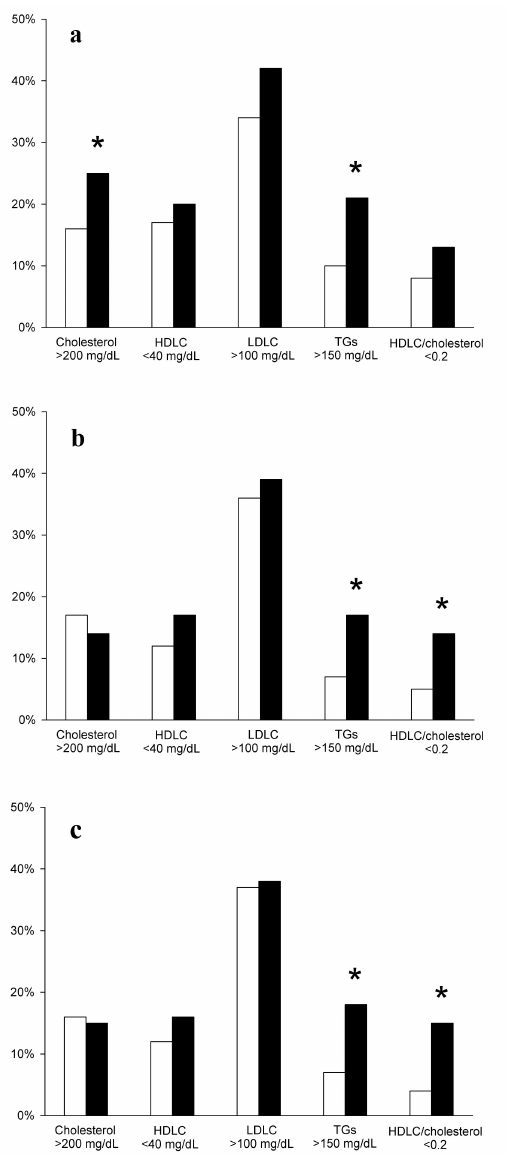
Figure 1. Percentage of abnormal values of particular parameters of lipid profile in patients with TSH < 2.5 mIU / L (white bars) and in patients with TSH ≥ 2.5 mIU / L (black bars), evaluated in the whole group of 466 inpatients ( a ), in the group of 280 inpatients with normal thyroid tests ( b ) or in the group of 240 inpatients (after excluding 40 patients on L-thyroxine treatment) ( c ). Statistical evaluation was performed by the two-sided ratio comparison test. * p < 0.05 vs. patients with TSH < 2.5 mIU / L. Concerning thyroid antibodies, increased concentrations of TPOAbs and TgAbs occurred more frequently in subjects with TSH ≥ 2.5 mIU / L, when the whole group (n = 466) of patients was considered (Table 2a). However, in the group of 280 inpatients with normal thyroid tests or after excluding L-thyroxine replacement (n = 240), only TPOAb concentrations occurred more frequently in subjects with TSH ≥ 2.5 mIU / L (Table